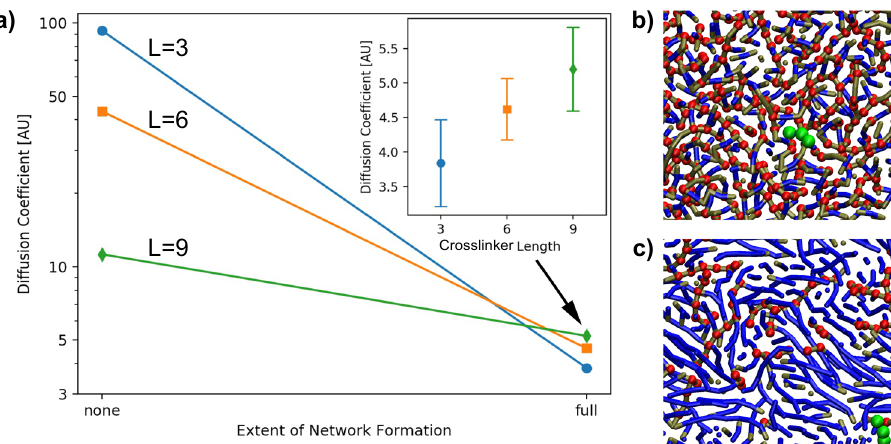
Fig. 4 Simulation Result for Diffusion Coef fi cient. a Diffusion coef fi cient of a probe molecule in crosslinkers of different spacer lengths (L = 3, 6, and 9) before and after the formation of a polymer network. The inset shows the diffusion coef fi cient of the probe molecule (i.e., a molecule 3 beads long), representing silver neodecanoate as a function of the crosslinker spacer length in the formed network. Snapshots from the simulations of the probe molecule (green molecule) in a network formed with crosslinker ( b ) L = 3 and ( c ) L = 9. The red balls represent crosslinking points while the blue parts are the bridging segments of the crosslinker. The high density of crosslinking points of the L = 3 system creates a tight polymer network that impedes diffusion of the probe molecule. In comparison, the L = 9 system allows for less constrained diffusion of the probe molecule due to its lower density of crosslinking points and longer segments between crosslinking